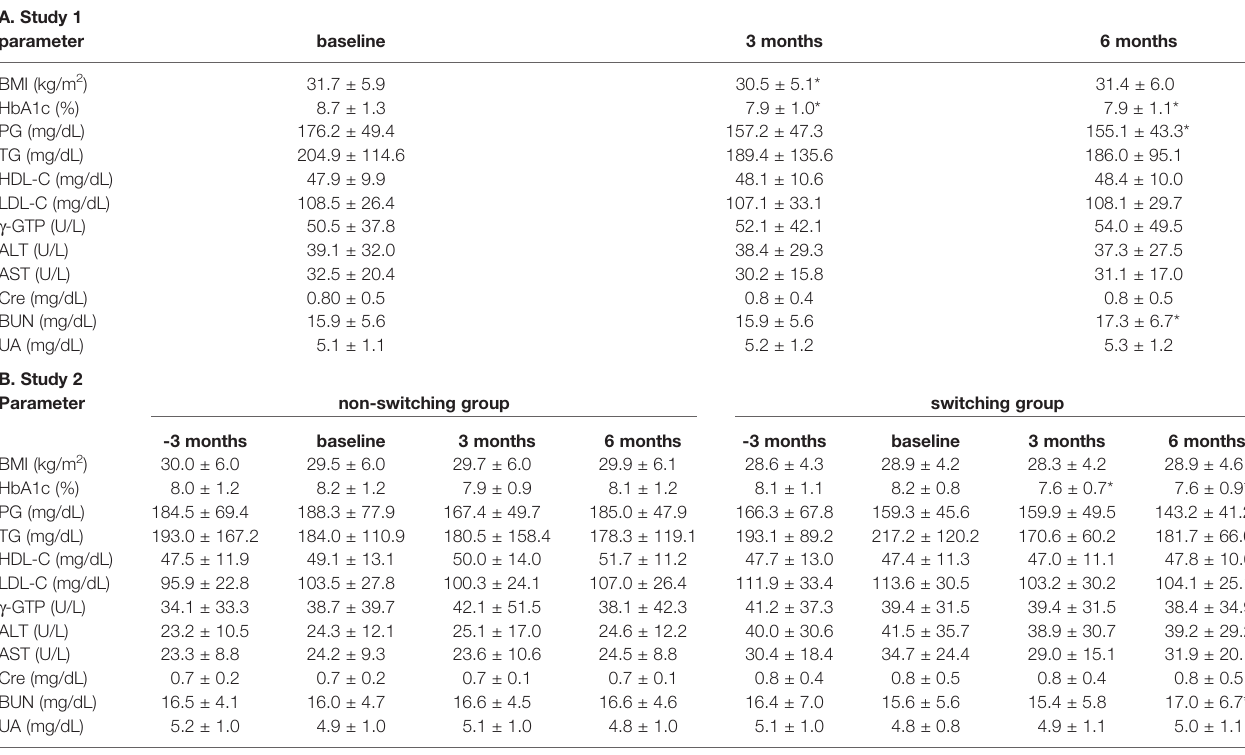
TABLE 2 | Time course of various clinical parameters after switching from DPP-4 inhibitor to